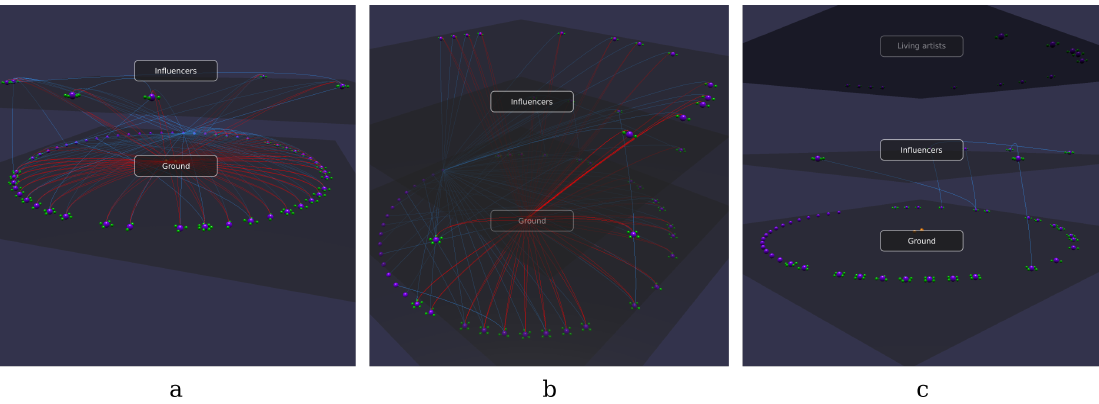
Figure 12. Use Case #2, Question 2: A semantic plane hosting influencers is created on top of the ground plane ( a ). A second semantic plane containing the living artists stands above the semantic plane of the influencers ( b ). No links between these two planes exists ( c ). At the bottom, the rest of the knowledge base.